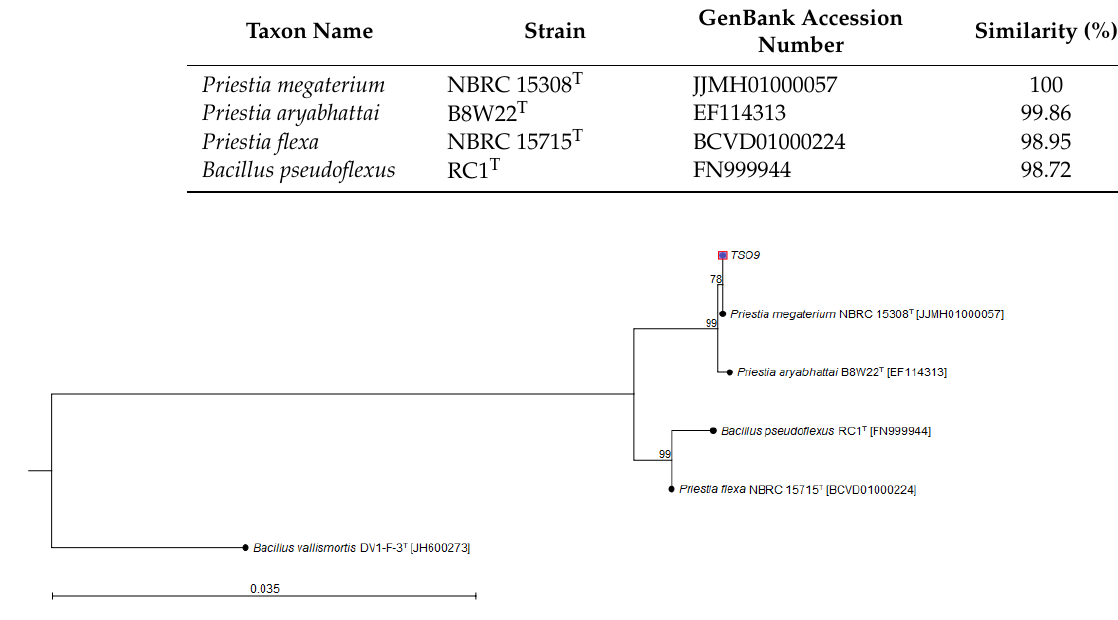
Figure 1. Phylogenetic relation between strain TSO9 and closely related species (based on the 16S rRNA gene): Priestia megaterium NBRC 15308T (JJMH01000057); P. aryabhattai B8W22T (EF114313); P. flexa NBRC 15715T (BCVD01000224), and Bacillus pseudoflexus RC1T (FN999944). B. vallismortis DV1-F-3T (JH600273) was used as an outgroup. This relation was constructed by CLC Sequence Viewer v 8.0.0 with the nucleotide distance measure Jukes–Cantor, and the neighbor-joining construction model (based on 1000 bootstrap replications). Scale bar (0.035) represents the number of nucleotide substitutions per